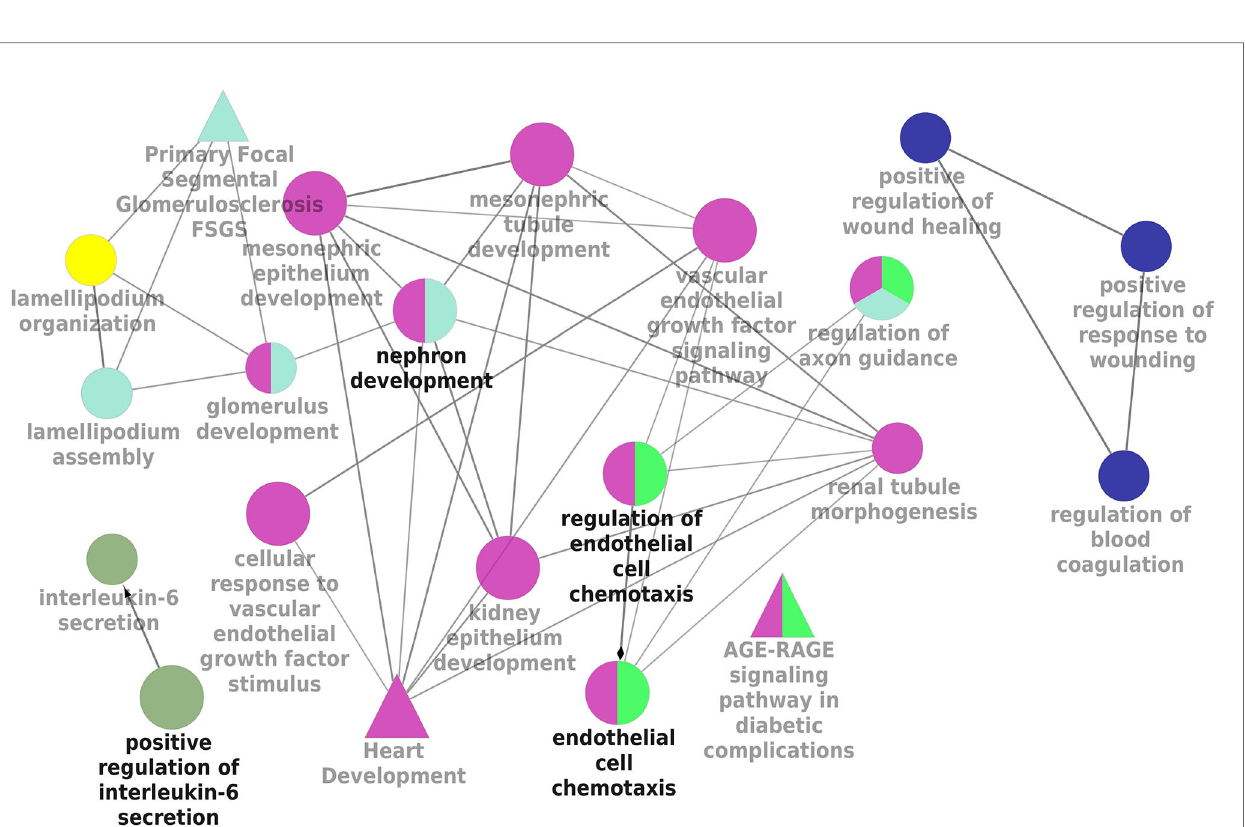
FIGURE 3 | Interrelation analysis of pathways downregulated DEGs by examining KEGG processes in ClueGO.